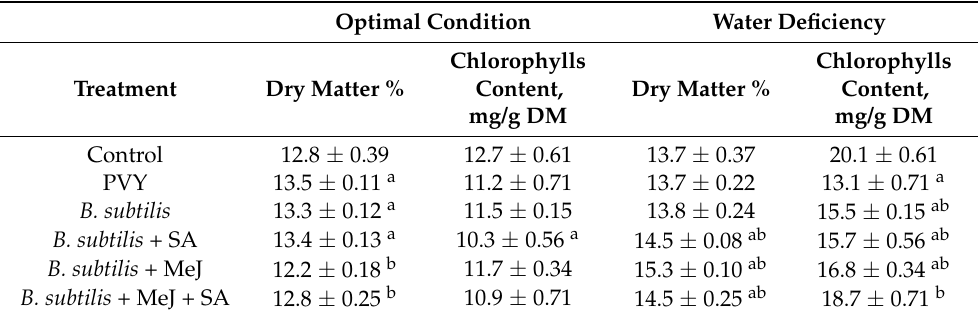
Table 1. Effect of PVY infection and the mixture of B. subtilis with SA and MeJ application on total dry matter and chlorophyll contents.